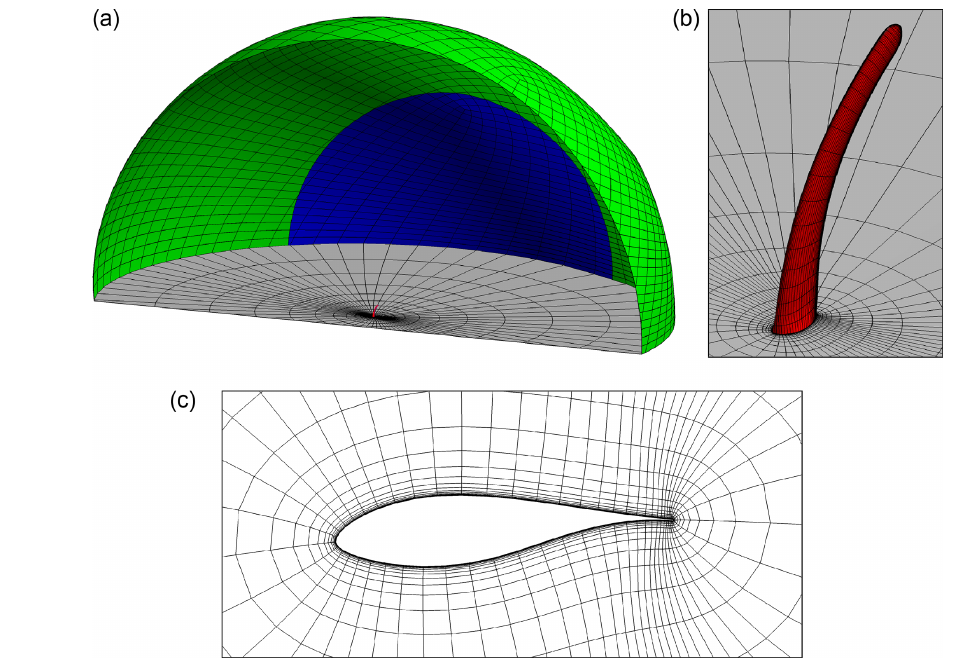
Figure 9. Visualization of the EllipSys3D mesh. For clarity, only one out of every four grid lines is shown, and half of the semi-spherical domain is not depicted. (a, b) Overview and detail of the boundary condition distribution (green for inlet, blue for outlet, gray for symmetry, and red for wall). (c) Cross-sectional mesh around the tip shape, taken at one-third of the total projected length (starting from the